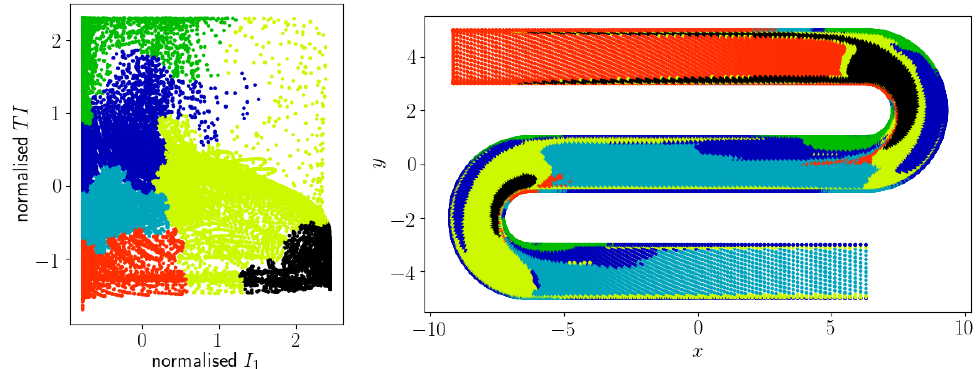
Figure 3. Cluster classification in feature space ( left ) and physical space ( right